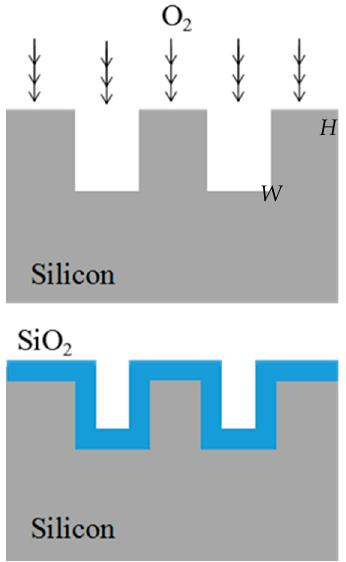
Figure 2. Mechanism of dry oxidation on silicon microchannel.